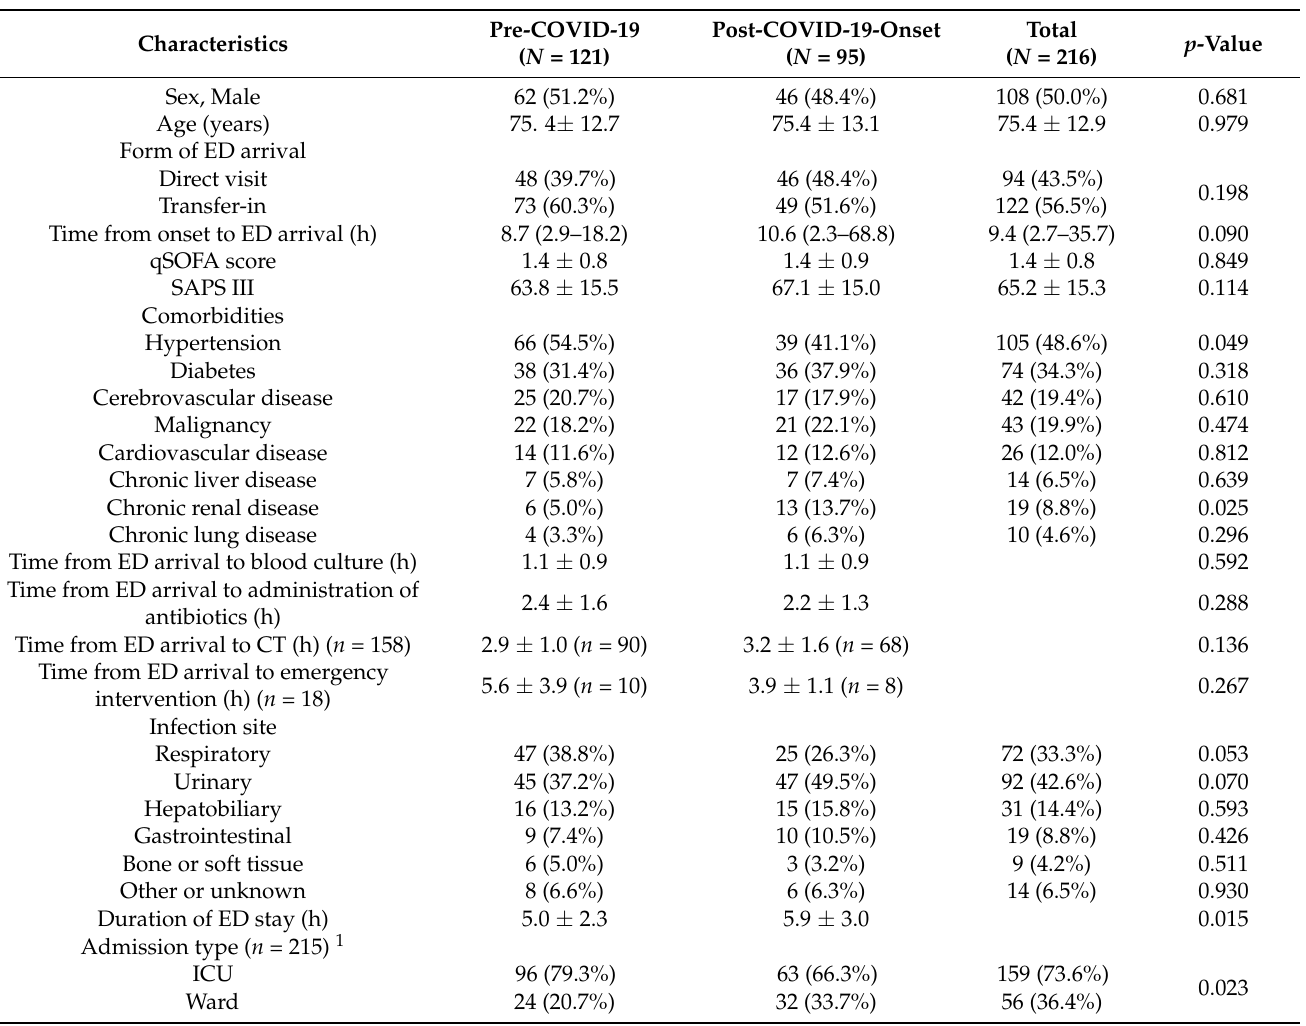
Table 1. Comparison of baseline and clinical characteristics in the pre-COVID-19 and post-COVID- 19-onset